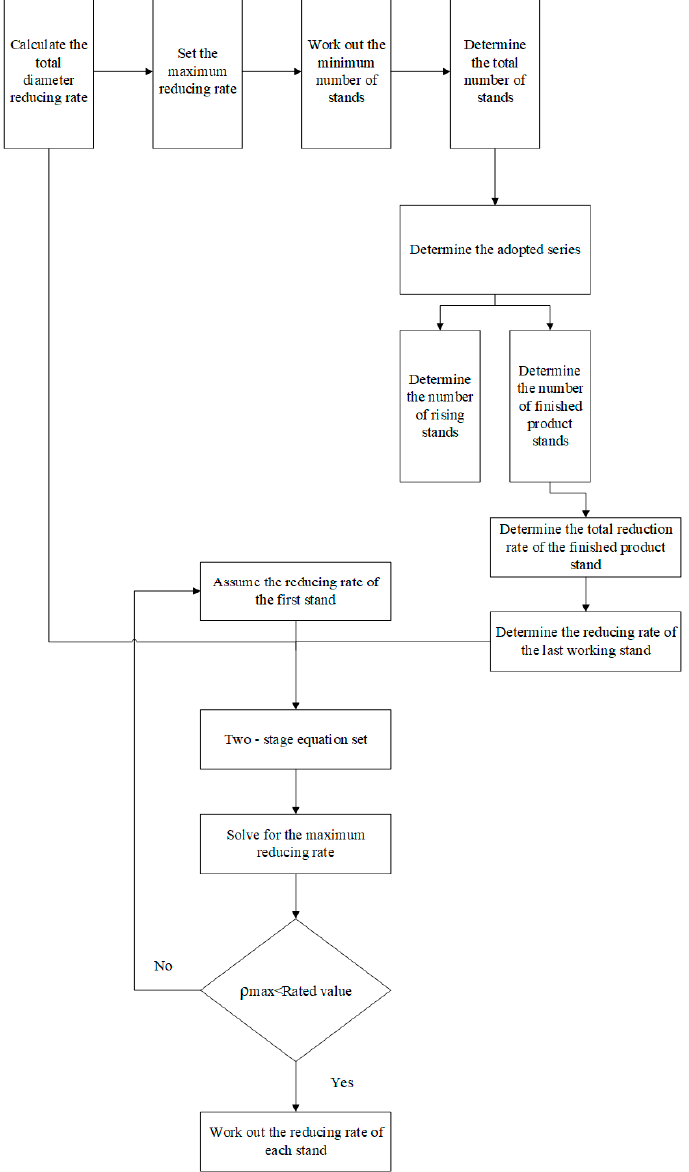
Figure 5. Flow chart for the solution.